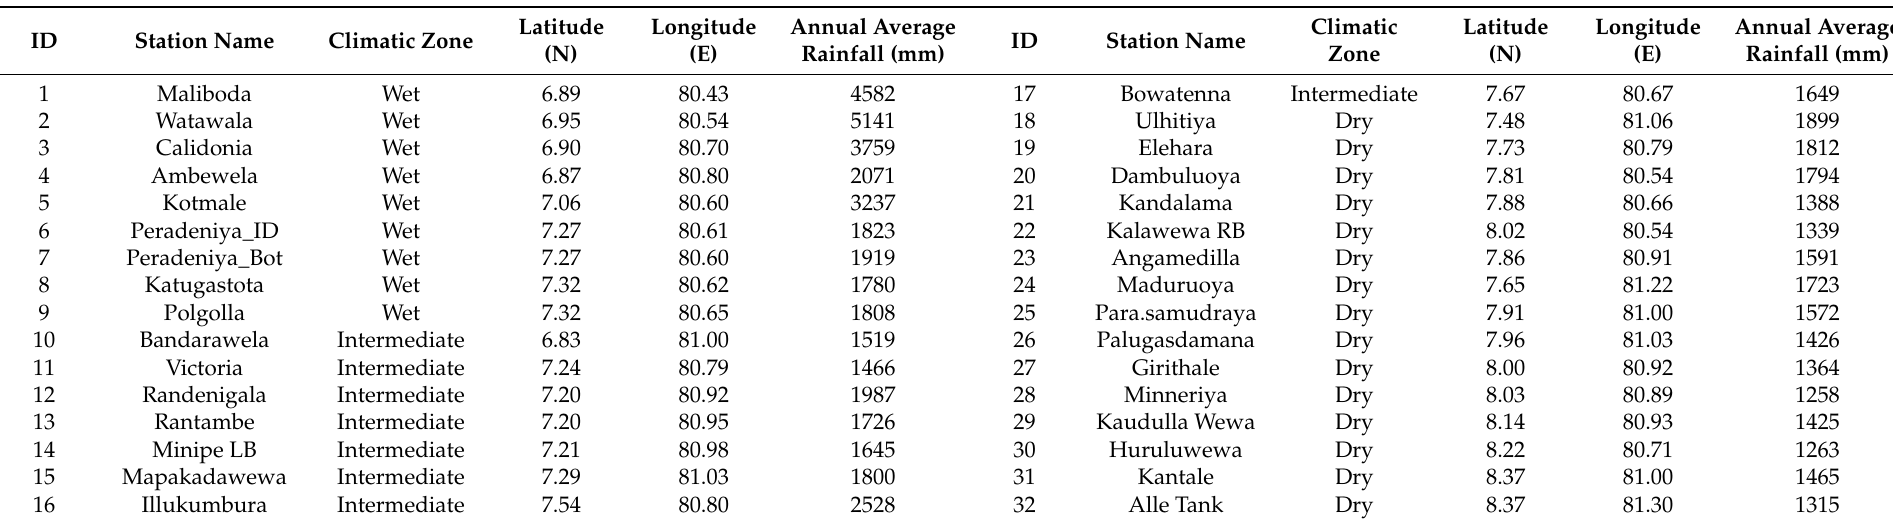
Table 2. Daily rain gauges in the Mahaweli River basin with names, climatic zones, locations, and annual average rainfall in